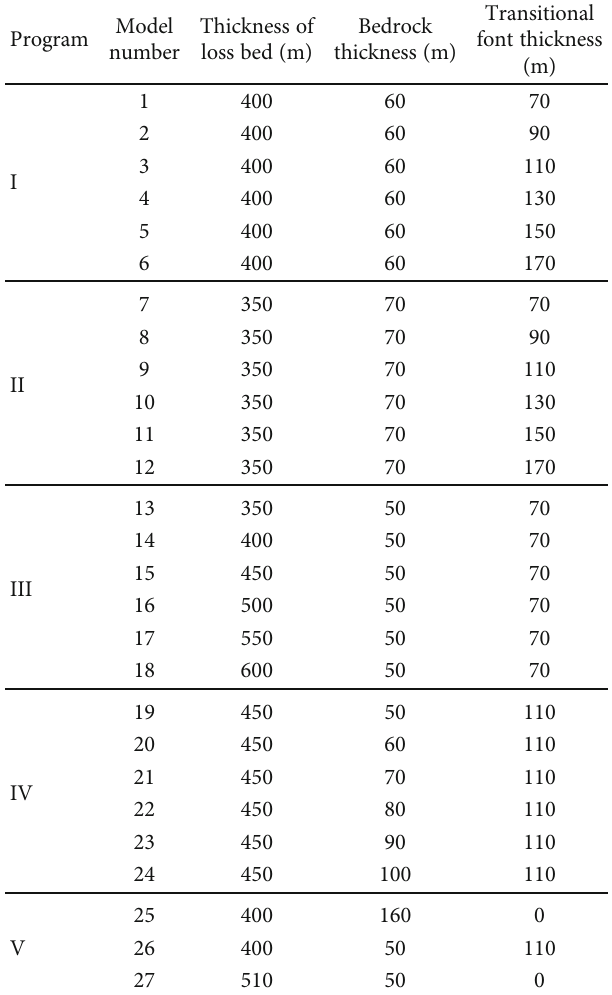
Table 2: Simulation